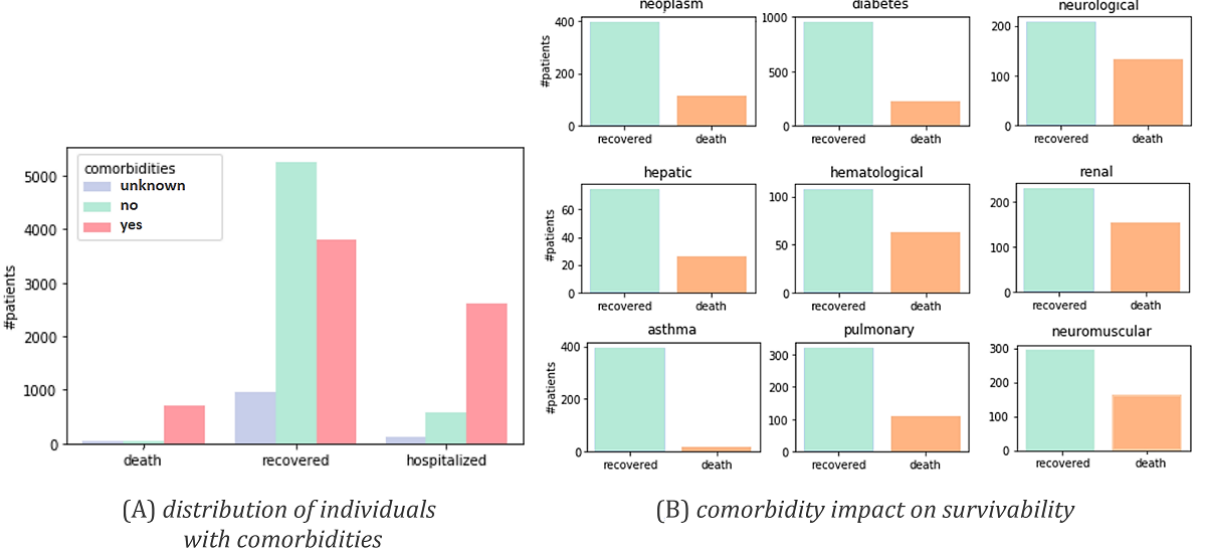
Figure 3. Cohort statistics: (A) distribution of individuals with one or more comorbidities among deaths, recovered cases, and hospitalizations; and (B) association between individual comorbidities and survivability